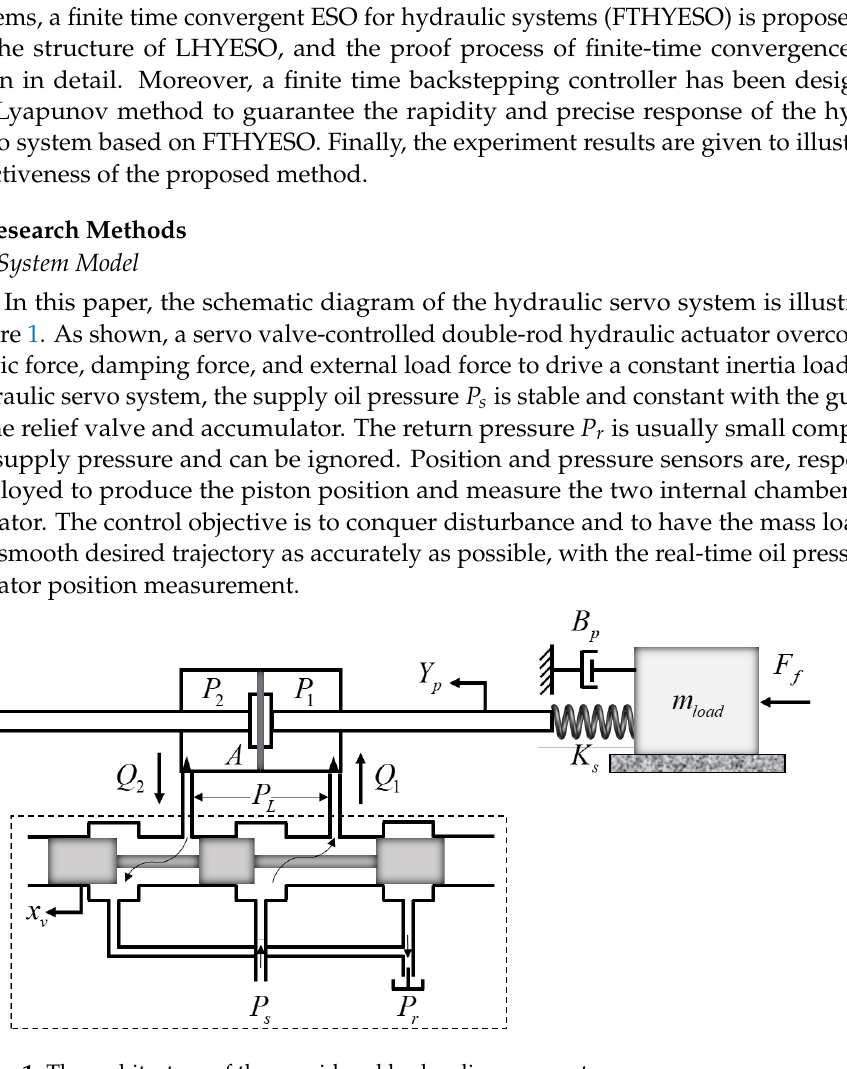
Figure 1. The architecture of the considered hydraulic servo system.